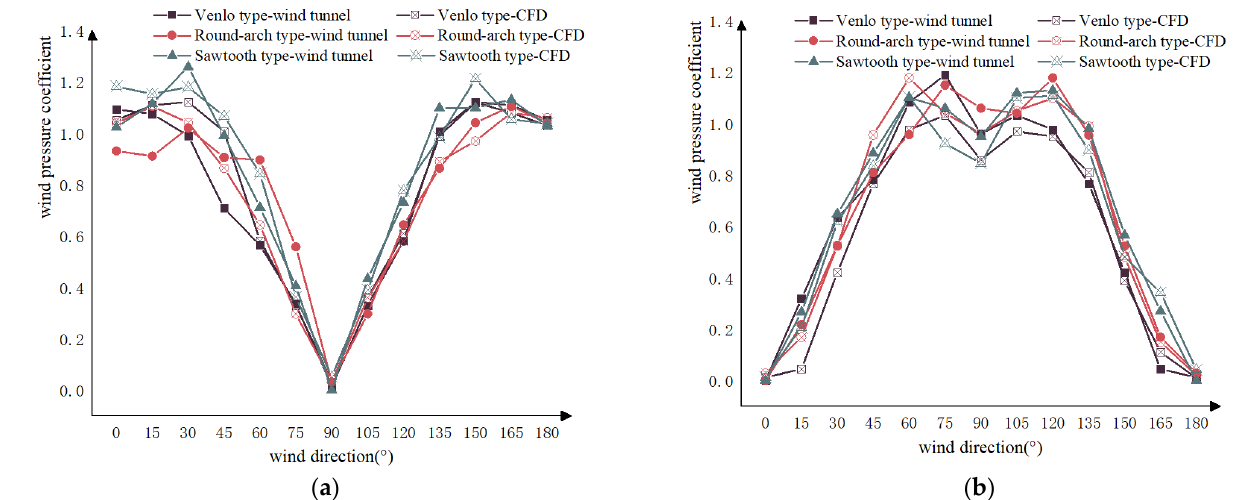
Figure 10. Variation of wind tunnel test and CFD wind pressure coefficient for each wind direction in the X/Y direction. ( a ) X-direction ( b ) Y-direction.